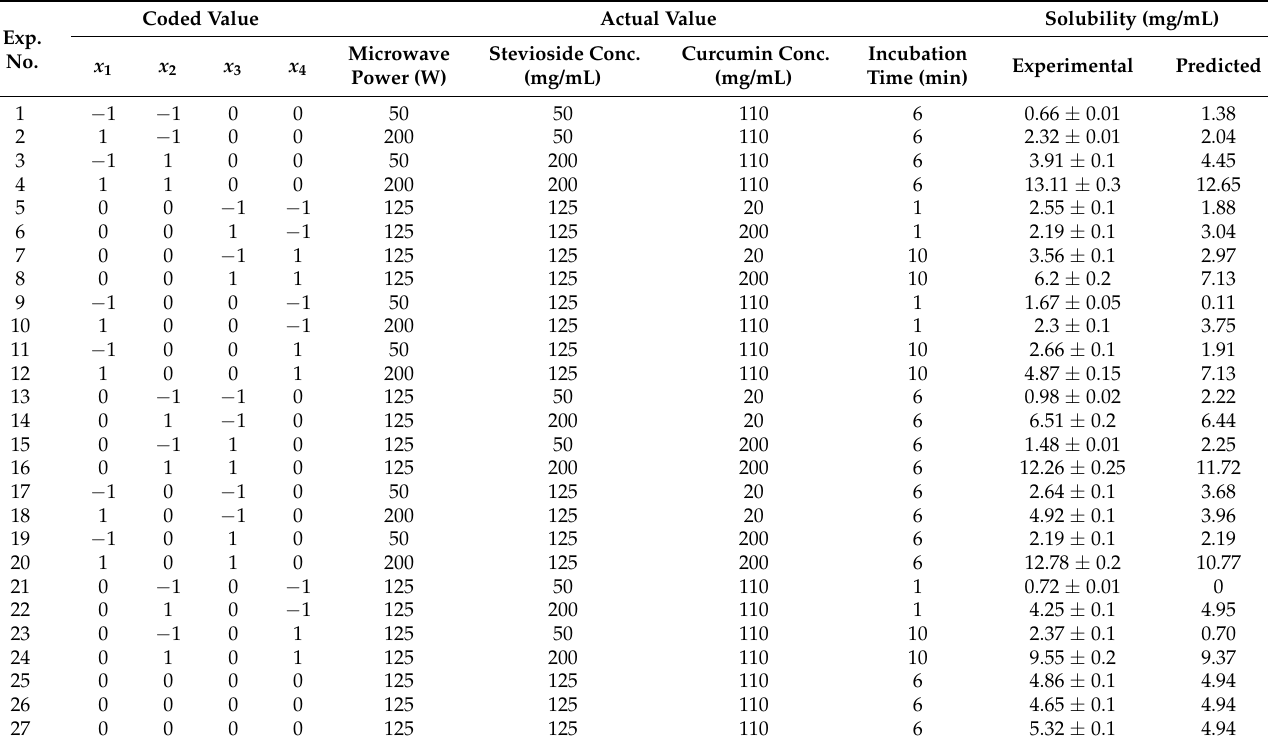
Table 3. Box–Behnken design matrix for the experimental design and the predicted responses for curcuminoid solubility. Exp.